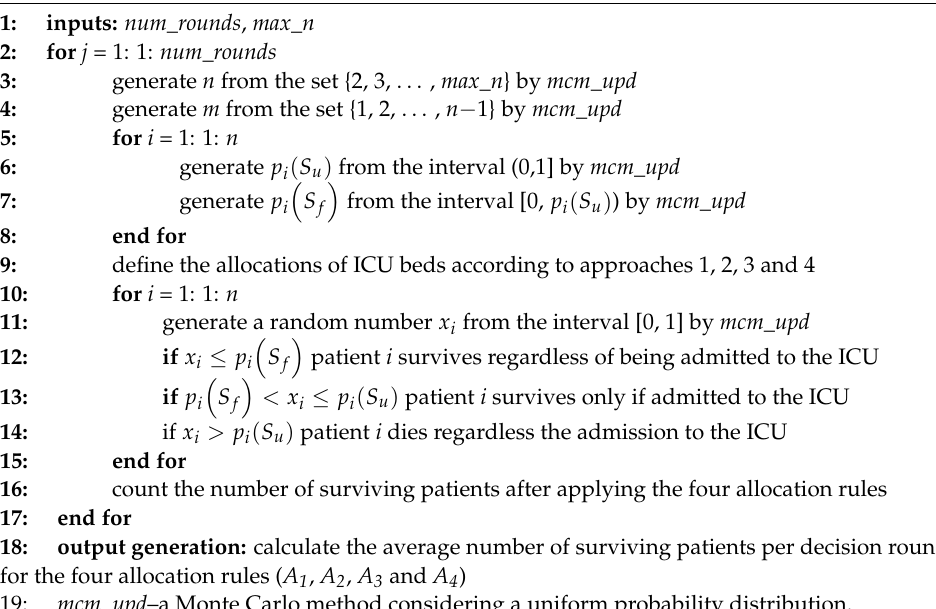
Algorithm 1. Simulation algorithm developed to compare the approaches for tackling the ICU allocation problem.